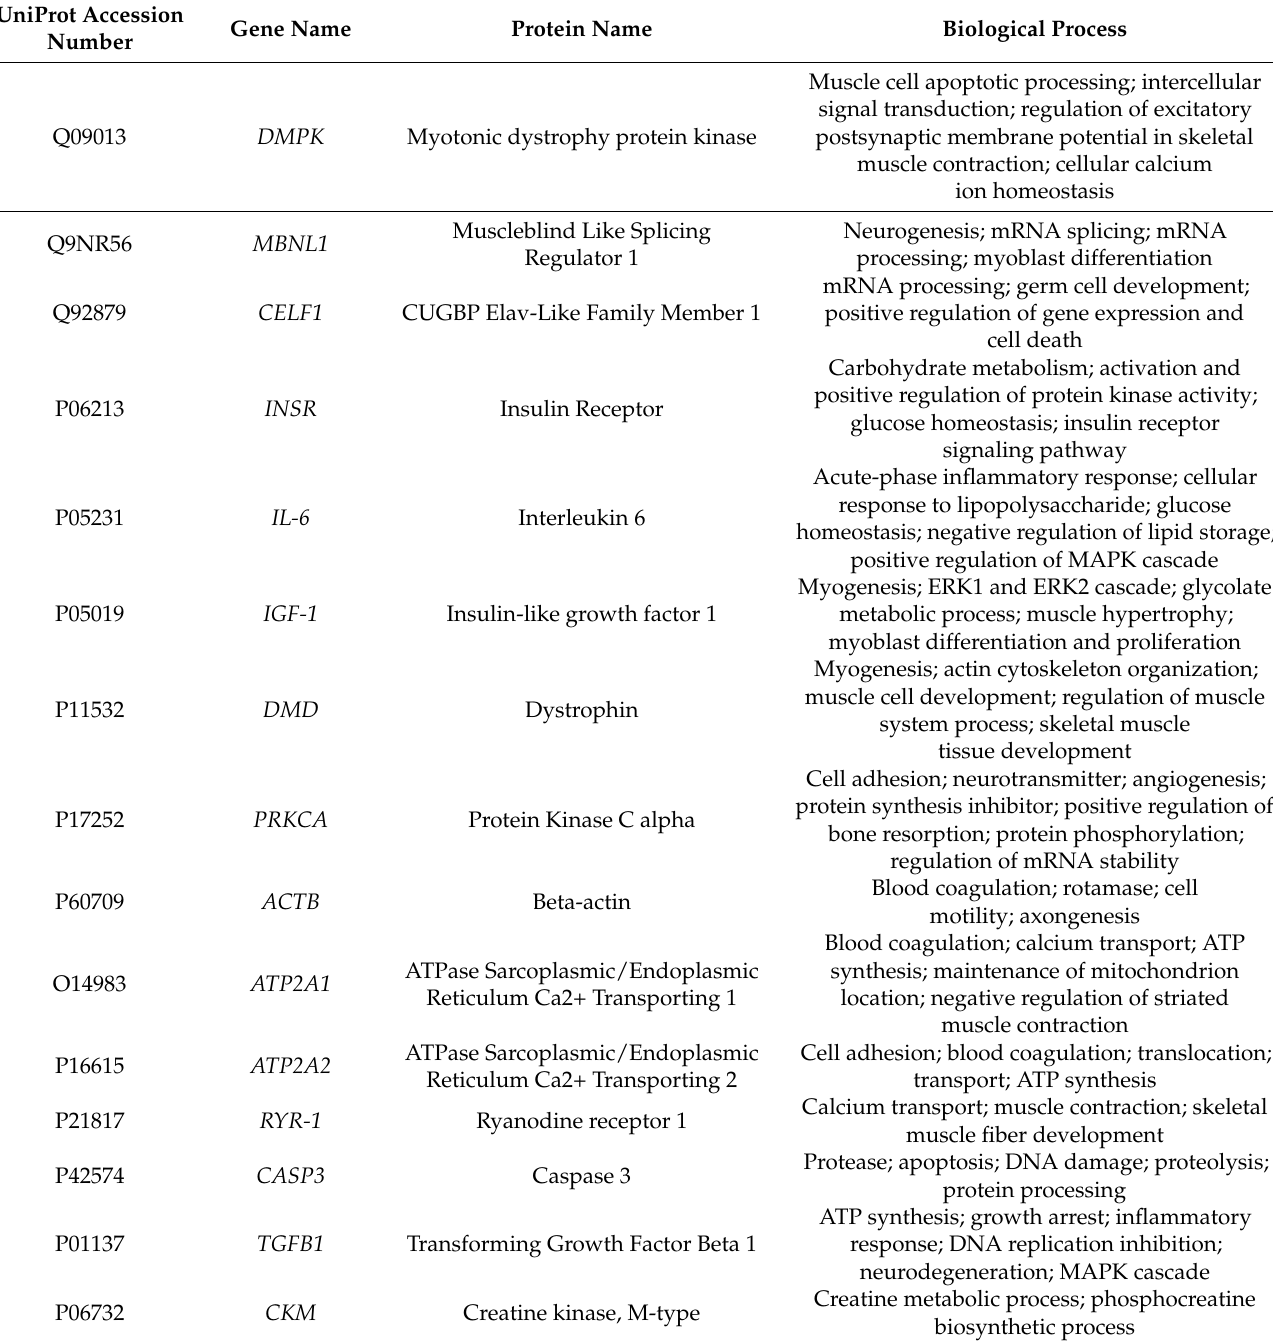
Table 2. Detailed list of common genes identified in DisGeNET and VOSviewer analysis. Proteomics DB (https://www.proteomicsdb.org/(accessed on 21 December 2022) and UniProt (https://www. uniprot.org/ (accessed on 21 December 2022) were used to investigate the biological processes in which these genes participate. More information on their subcellular localization and molecular function are presented in Table